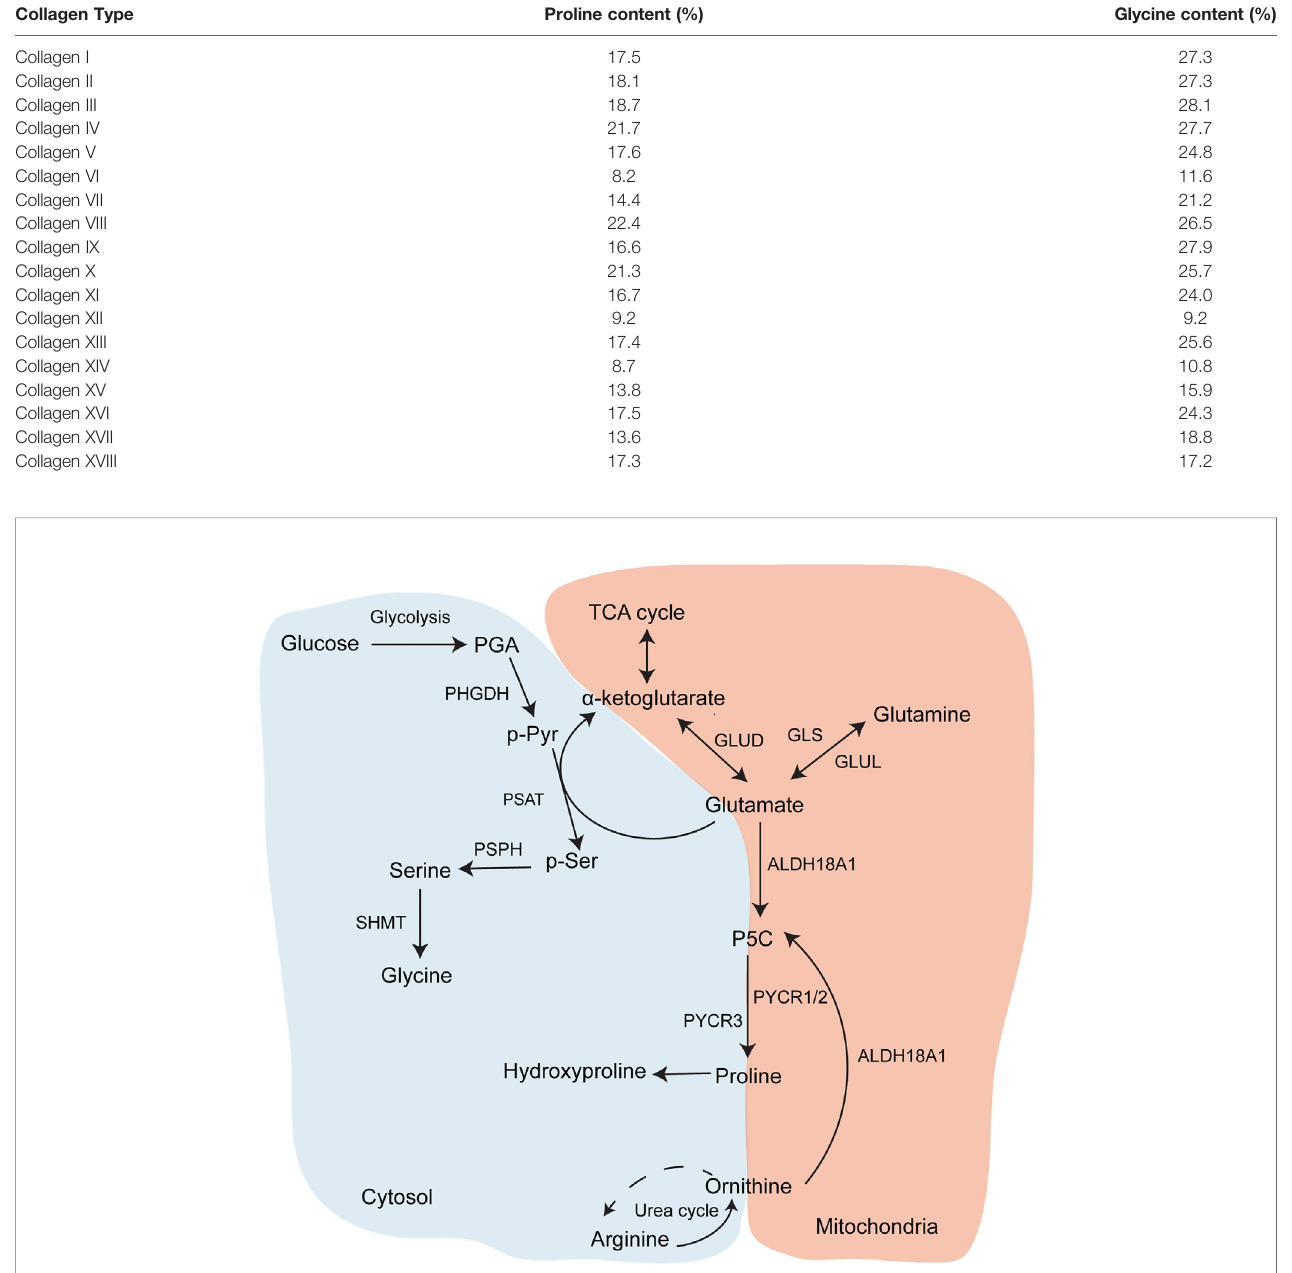
TABLE 1 | A list of collagens with the percentage of glycine and proline residues in